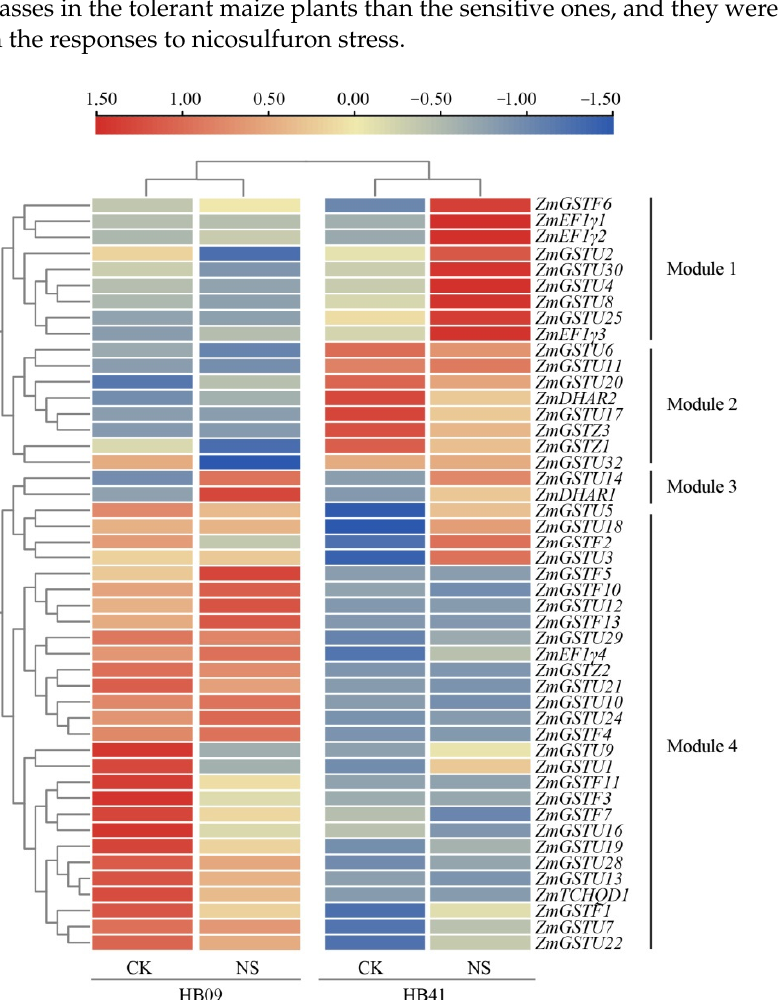
Figure 5. Hierarchical clustering of gene-expression data of ZmGST genes in Zea mays under nicosulfuron stress. The color bar represents the relative signal intensity values, with the color ranging from blue to red indicating low–high expression abundance. The ZmGST gene names are mentioned on the right, and the two maize genotypes and the treatment are indicated at the bottom of each column. CK, untreated control; NS, nicosulfuron treated at 60 g a.i. ha − 1 .